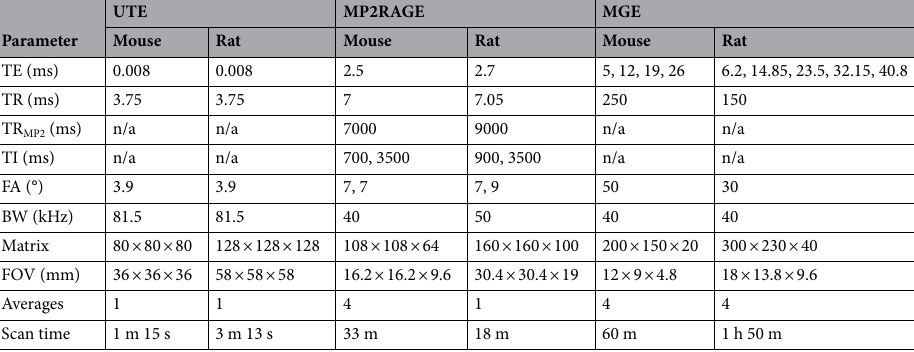
Table 1. MRI sequence parameters. UTE ultra-short echo time, MP2RAGE magnetization prepared 2 rapid acquisition of gradient echoes, MGE multi-gradient-echo, TE echo time, TR repetition time, TR MP2 MP2RAGE segment repetition time, TI inversion time, FA flip angle, BW receiver bandwidth, FOV